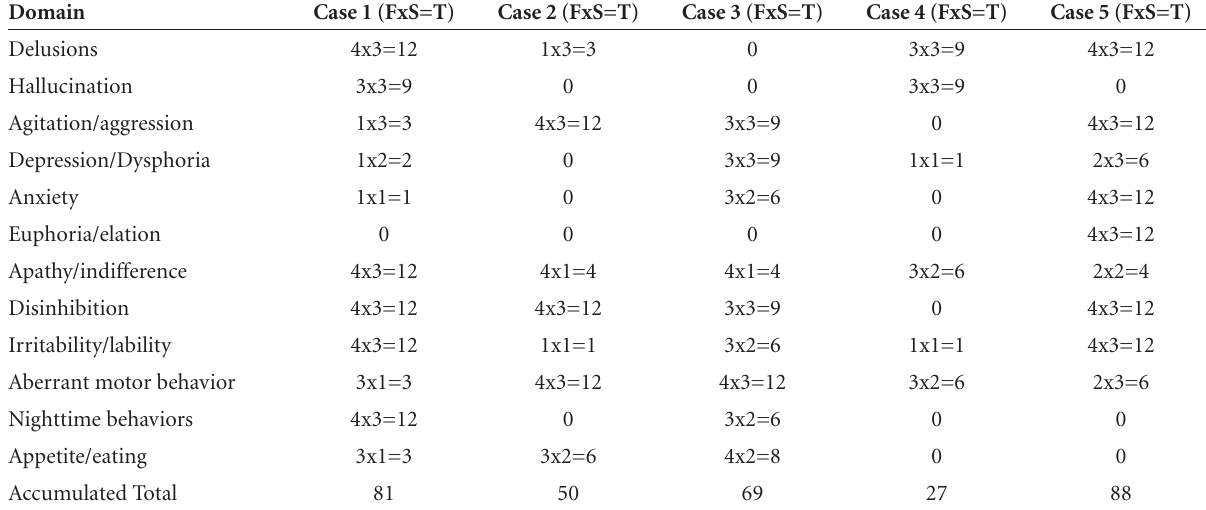
Table 2. Neuropsychiatric Inventory (NPI) of the fi ve cases.